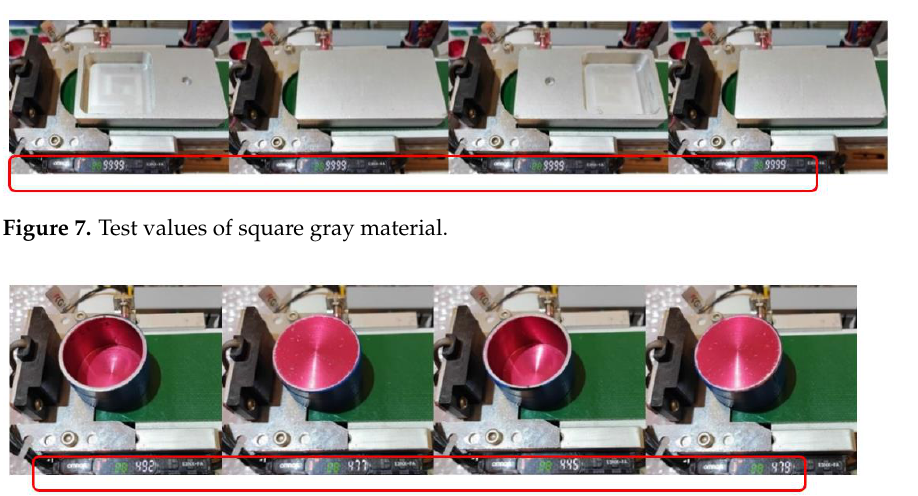
Figure 8. Test values of circular blue material.